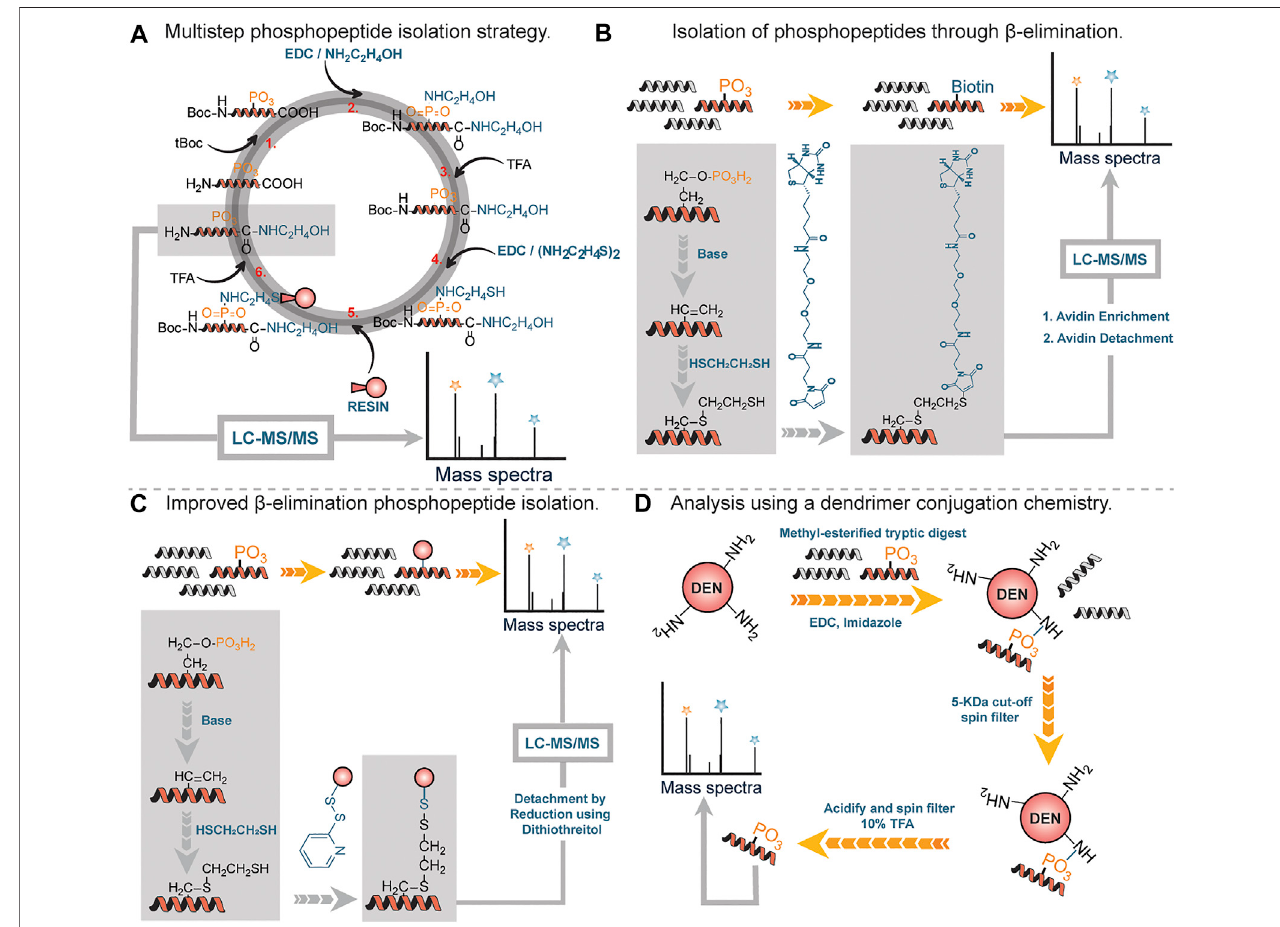
FIGURE 3 | (A) Multistep approach to phosphopeptide isolation. (B) Isolation and analysis of phosphopeptides through β -elimination of terminal phosphate, followed by alkylation with biotin. (C) Improved β -elimination strategy with a release by disul fi de bonds. (D) A 3-step reaction sequence for isolating phosphopeptide by using functionalized soluble